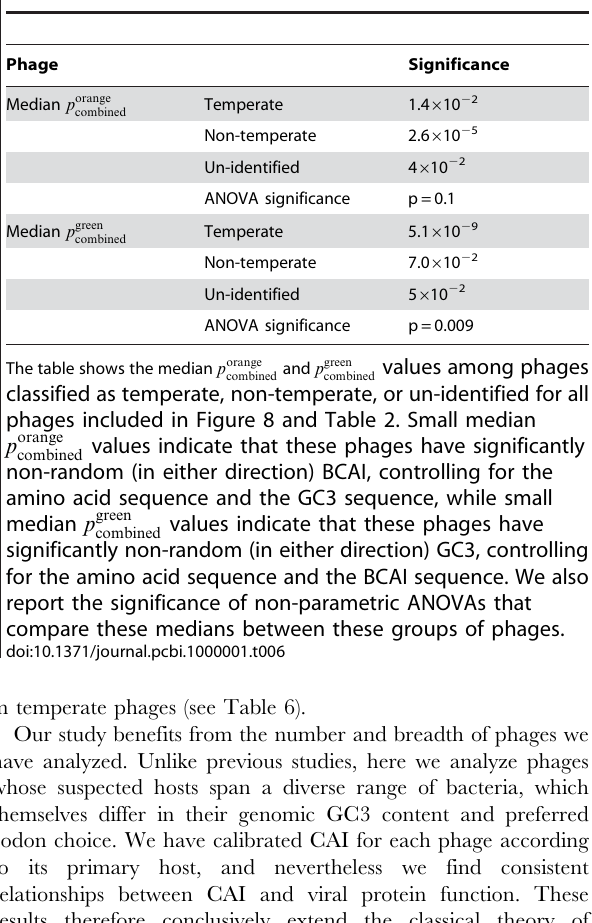
Table 6. Phage lifestyle versus codon